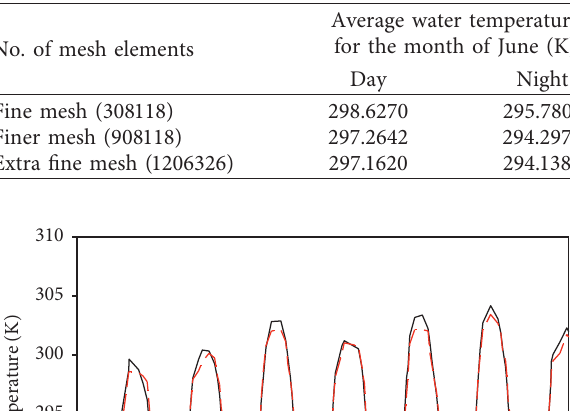
Table 3: Grid independence test (water depth � 5.6mm, slope angle � 1 ° , aspect ratio � 180, and Re � 9000) for water temperature averaged on the entire reactor volume.